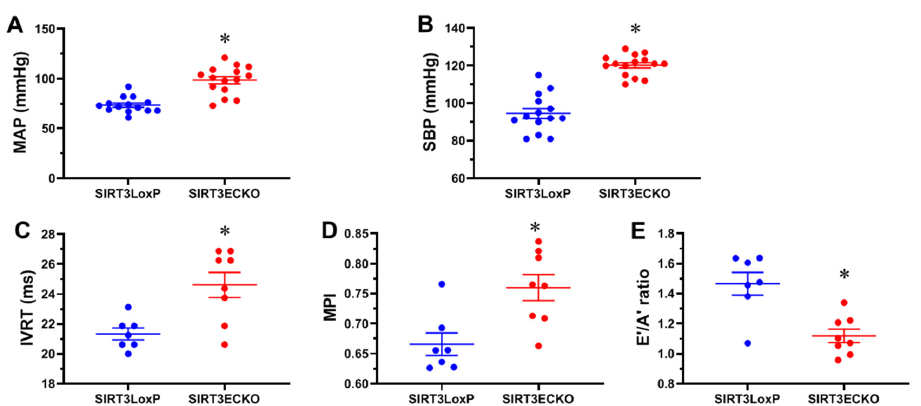
Figure 1. Loss of endothelial SIRT3 elevates blood pressure and impairs diastolic function in the female mice . ( A , B ) Mean arterial blood pressure (MAP) and systolic blood pressure (SBP) are